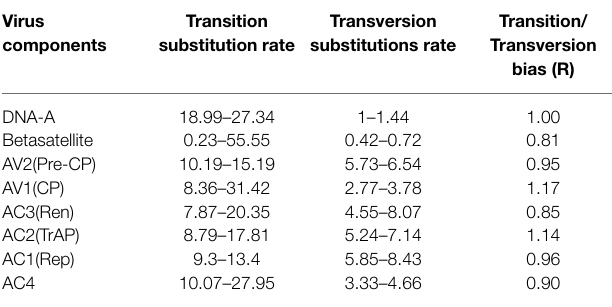
TABLE 2 | Estimation of substitution rate among DNA-A, open reading frames (ORFs), and betasatellite associated with Papaya Leaf Curl Disease (PaLCD) in India using the MEGA X